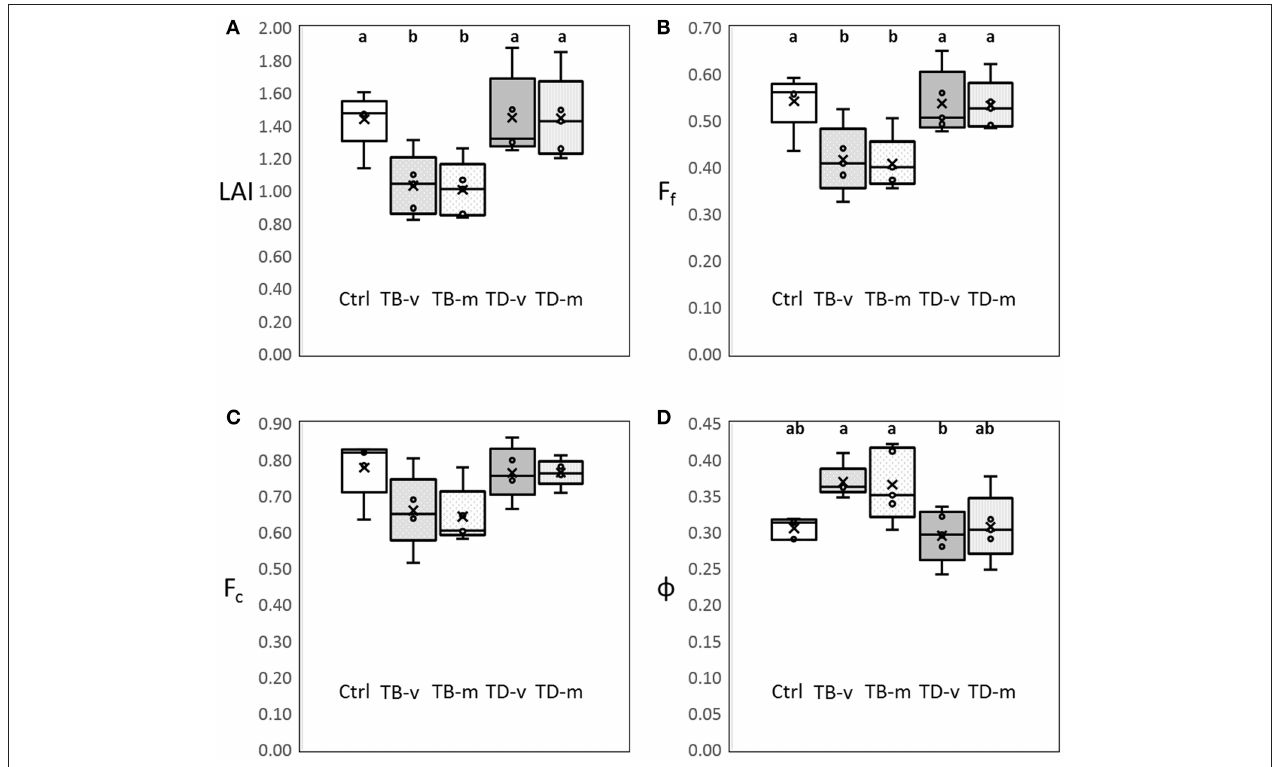
FIGURE 1 | Influence of leaf trimming on canopy structure parameters measured at mid-ripeness in the 2015–2016 growing season: (A) leaf area index (LAI); (B) Foliage projective cover (Ff); (C) Crown cover (Fc); (D) Porosity ( φ ) ( p < 0.05), no unites for each parameter. One-way ANOVA were conducted to compare different parameters at p < 0.05, and a, b were used to indicate statistically significant differences. Boxplot shows median value and standard deviation for each treatment groups. Control group (Ctrl), basal leaves removal at veraison (TB-v) at mid ripeness (TB-m), apical leaves removal at veraison (TD-v) at mid ripeness